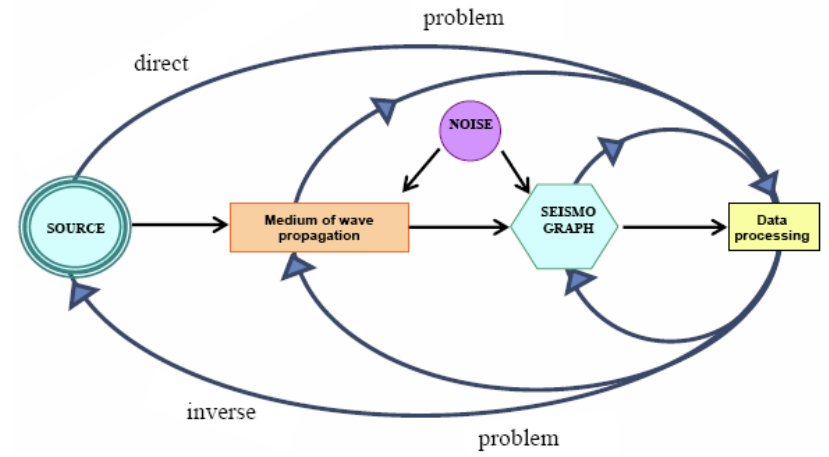
Figure 4. Diagram illustrating seismology as the analysis of complex information system linked to a diversity of specialized and interdisciplinary task of research and application